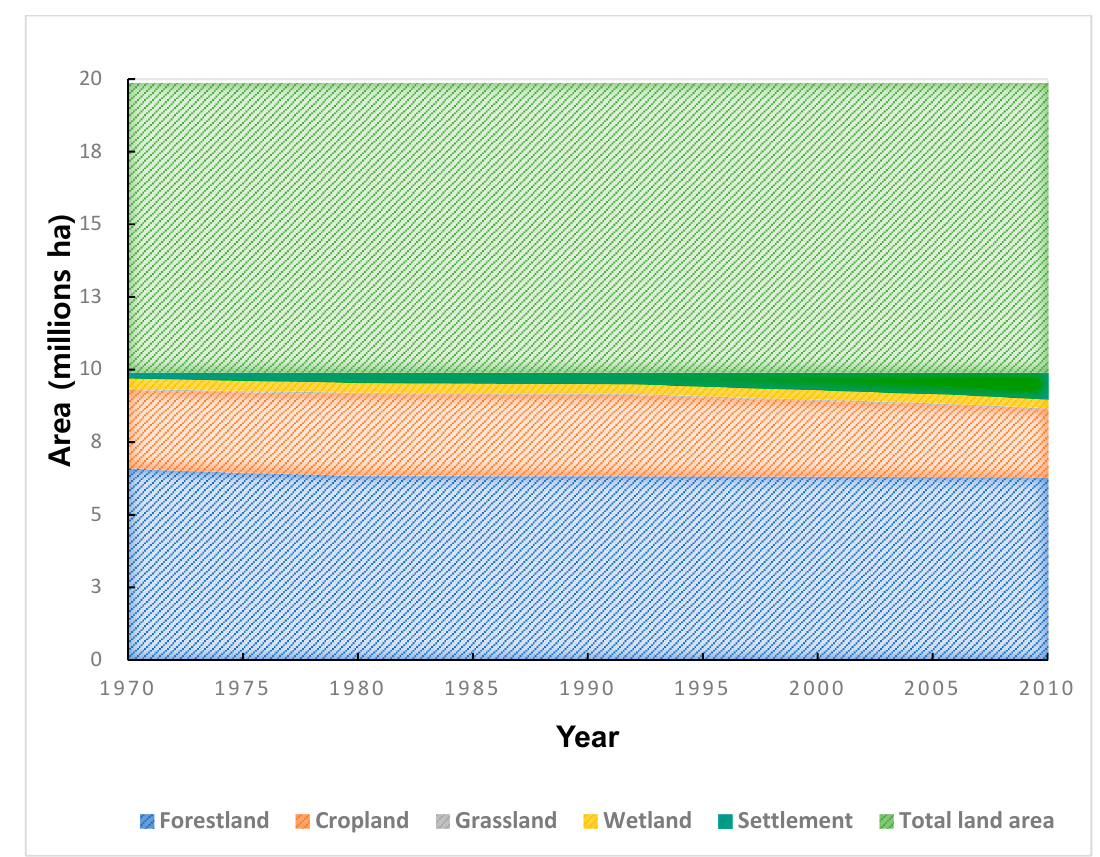
Figure 4. Annual areal estimates from aerial imagery analyses, interpolation, and extrapolation.